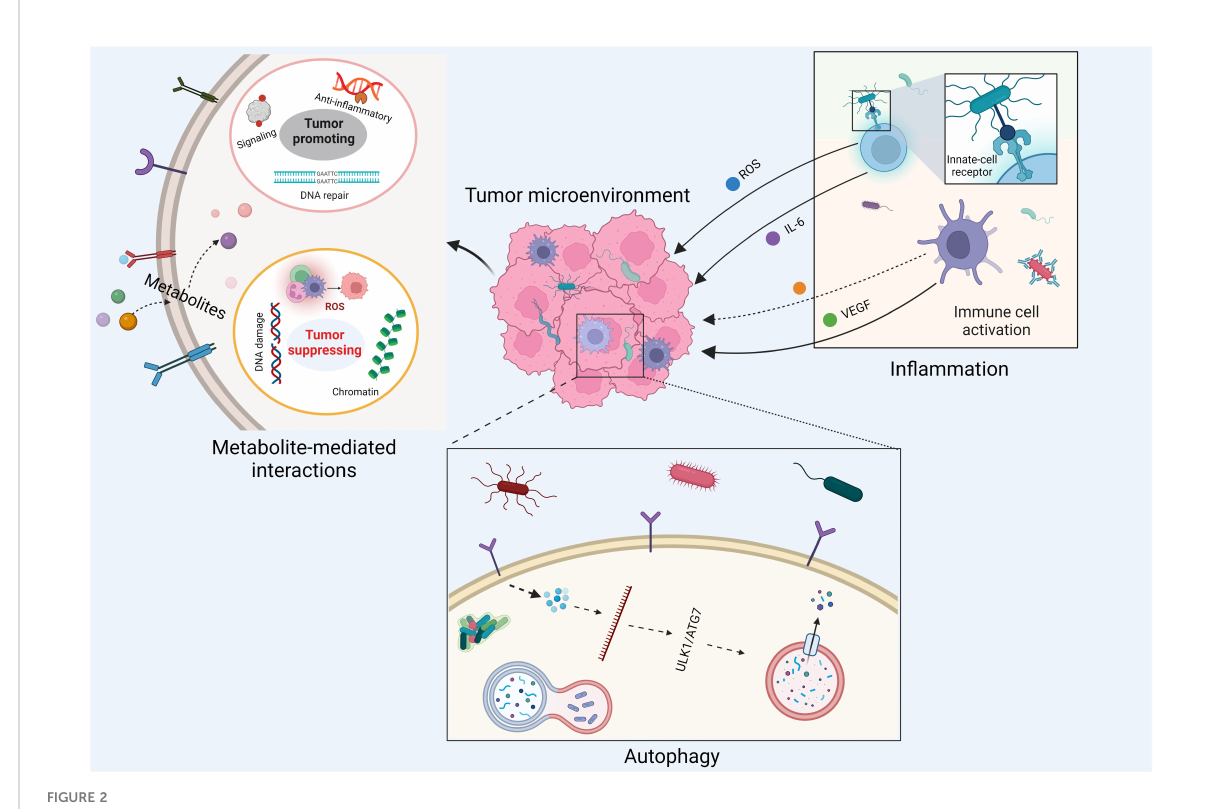
FIGURE 2 Impacts of tumor microbiome on cancer